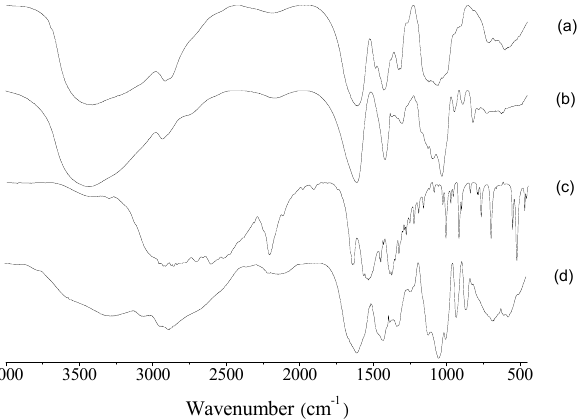
Figure 3. Fourier transform infrared (FTIR) spectra of ( a ) carboxymethyl chitosan (CMCS), ( b ) sodium alginate (SA), ( c ) tranexamic acid (TA), and ( d ) film 4#.